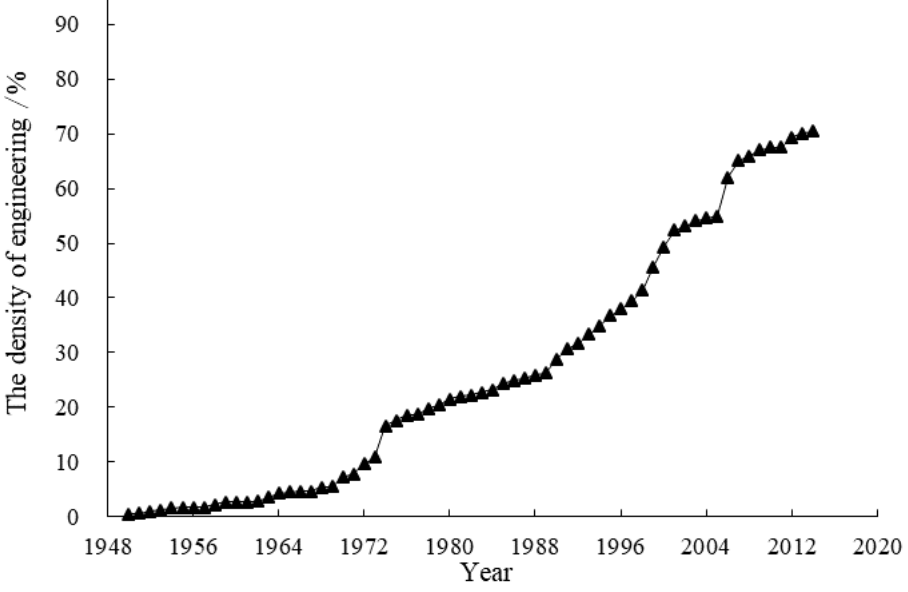
Figure 2. Density of wandering river regulation works in the lower Yellow River from 1960 to 2014.